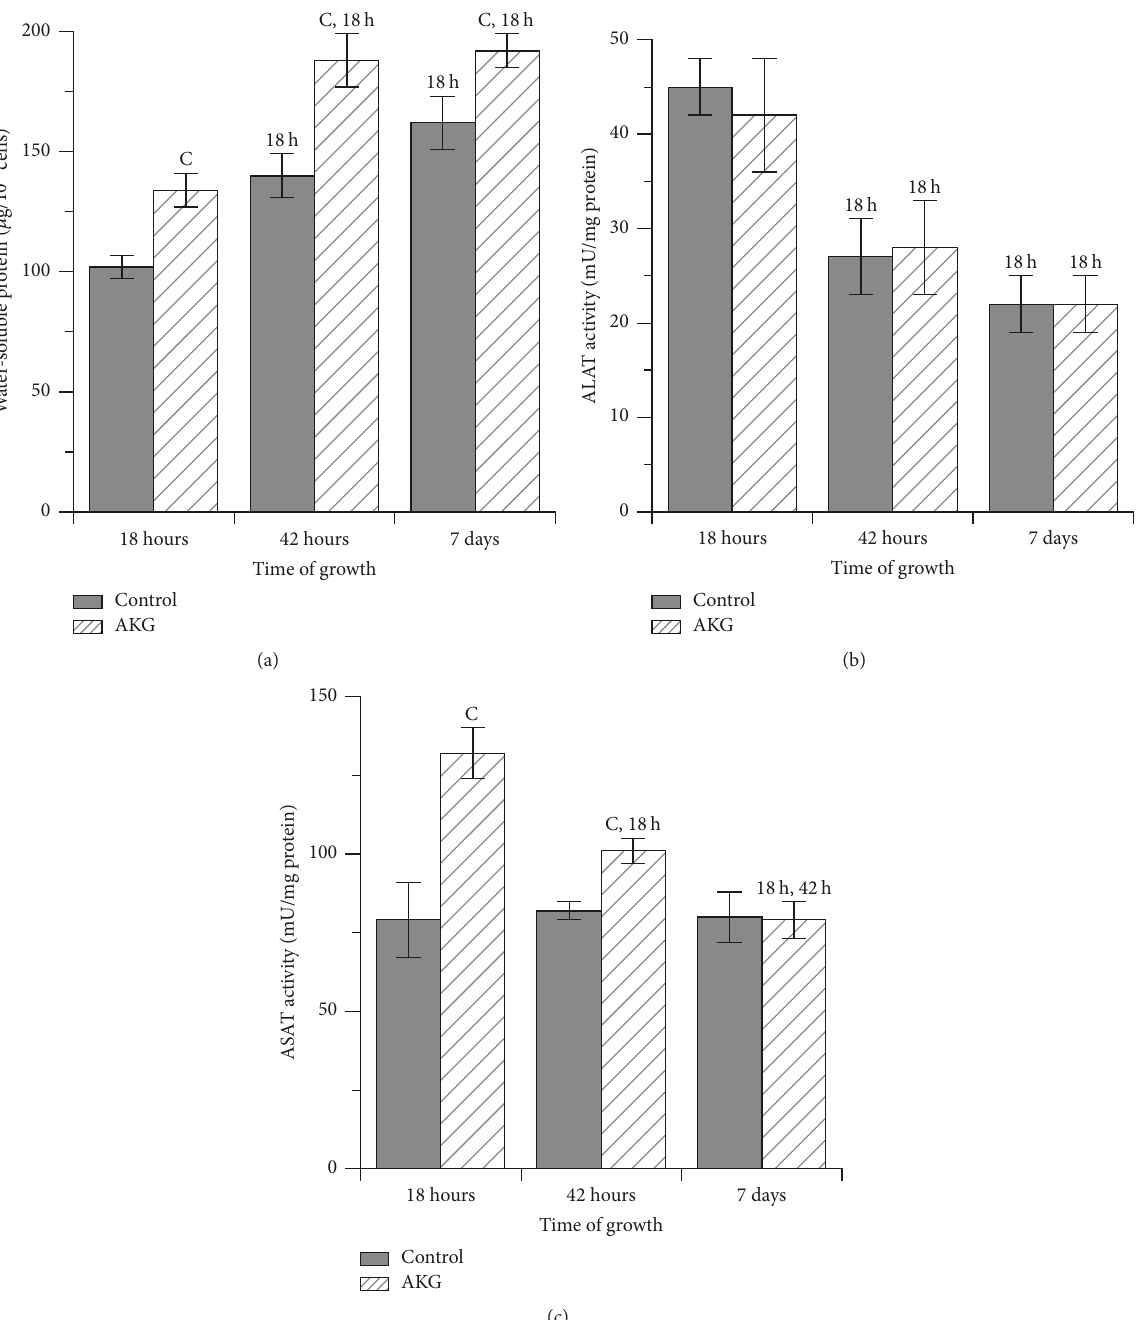
Figure 2: Levels of water-soluble protein (a), ALAT activity (b), and ASAT activity (c) in yeast S. cerevisiae cells grown during 7 days in the control medium or in the medium supplemented with 10 mM AKG. Results are shown as means ± SEM ( 𝑛 = 5 –8). C, significantly different from respective control values with 𝑃 < 0.01 using Student’s t -test; 18h, significantly different from respective values at 18h, and 42 h, different from respective values at 42 h with 𝑃 < 0.05 using Student-Newman-Keuls